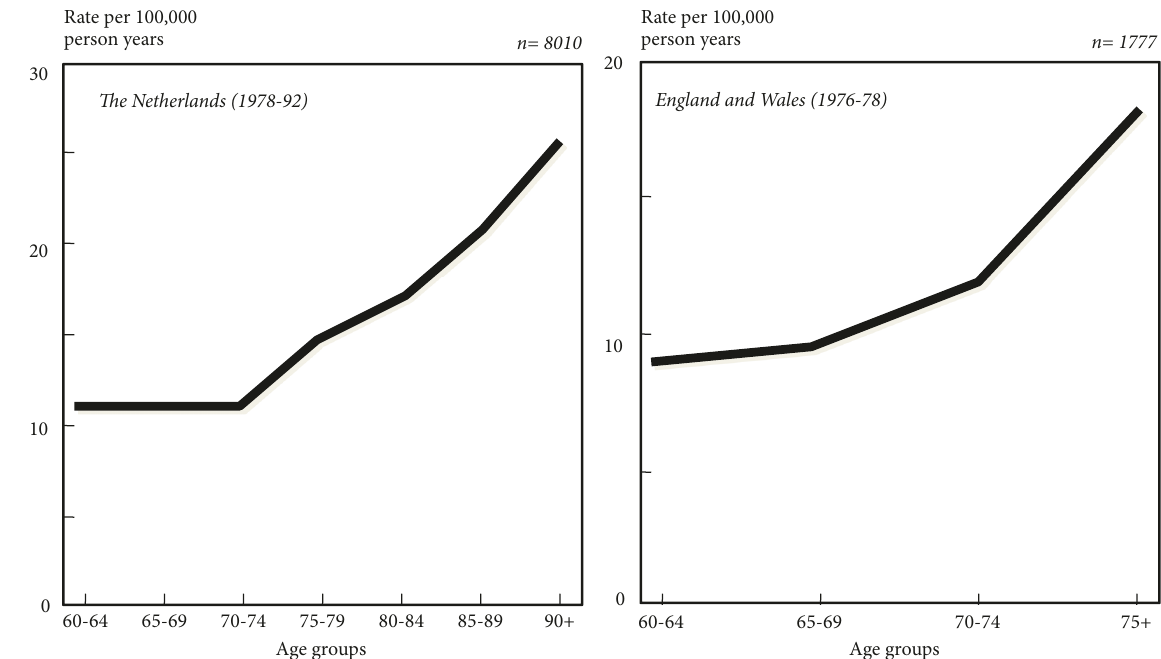
Figure 5: Annual first-contact rates for nonaffective psychoses in the elderly population ( > 60 years); based on case-register data. Source: [32], modified.